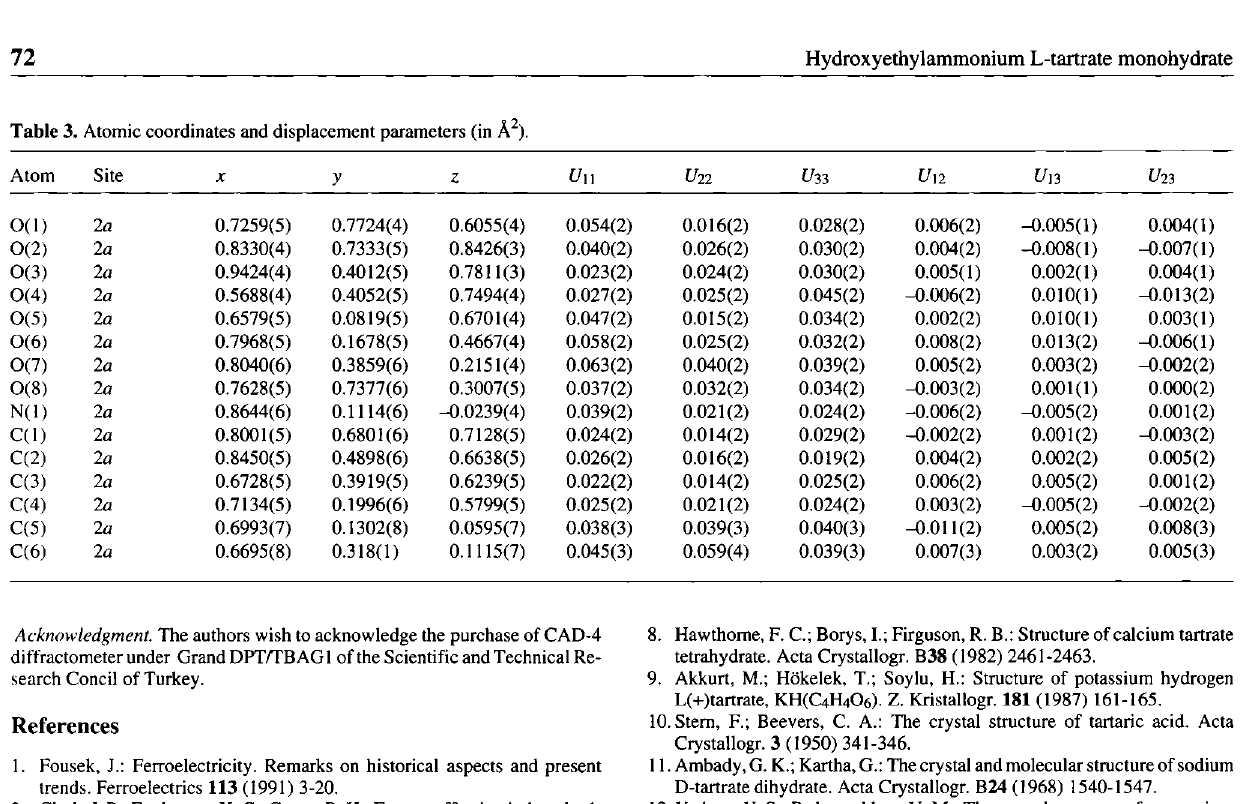
Table 3. Atomic coordinates and displacement parameters (in Ä 2